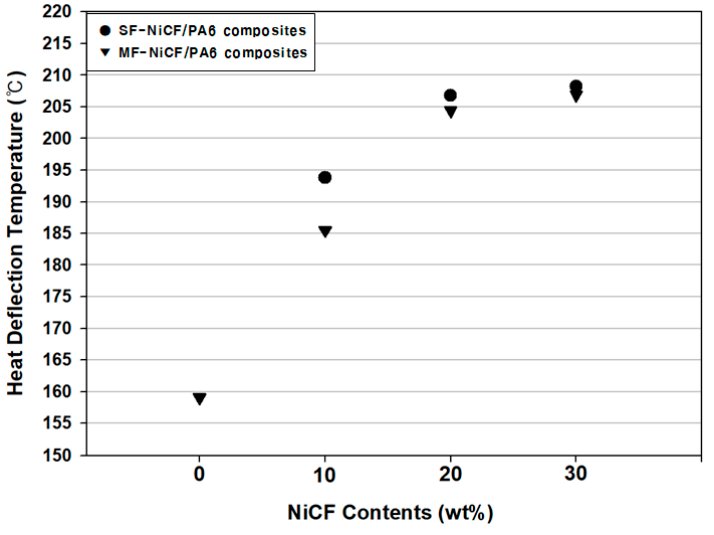
Figure 6. HDT values of the MF-NiCF/PA6 and SF-NiCF/PA6 composites with various NiCF con- tents.